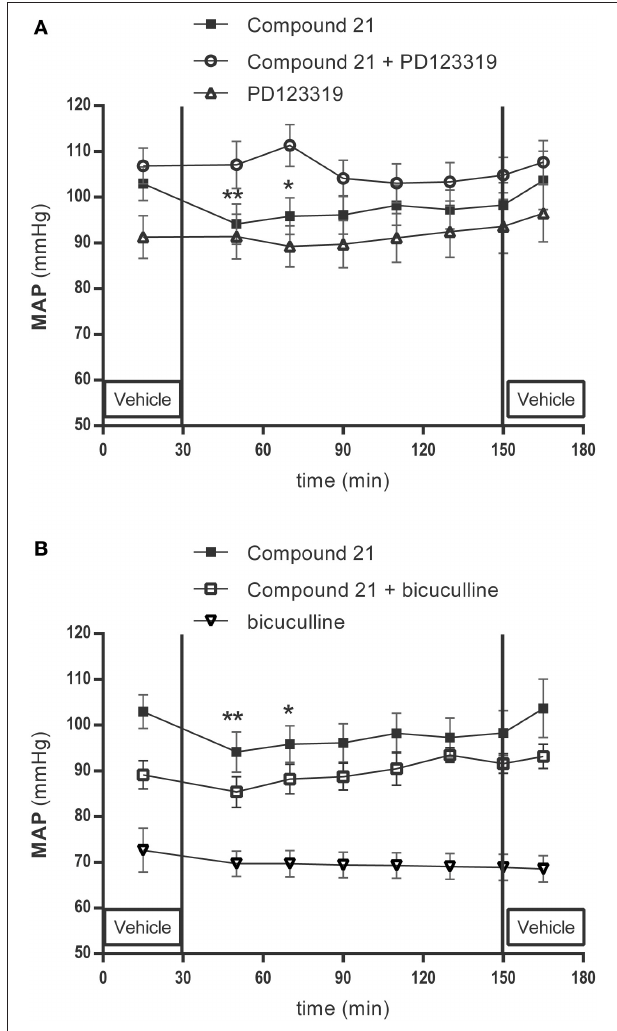
FIGURE 4 | Mean arterial pressure (MAP) measurement experiment: effect of infusion in the RVLM with the AT2R agonist C21 (0.05 µ g/ µ l/h) ( n = 6), co-infusion of C21 with the AT2R antagonist PD123319 (0.05 µ g/ µ l/h) ( n = 4) and infusion of PD123319 (0.05 µ g/ µ l/h) alone ( n = 9) (A) ; C21 (0.05 µ g/ µ l/h) infusion alone, co-infusion of C21 (0.05 µ g/ µ l/h) with the GABA-A R antagonist bicuculline (100 µ M) ( n = 7), or infusion of bicuculline alone ( n = 4) (B) on MAP in normotensive anesthetized Wistar rats. MAP was recorded every 2 s. C21, PD123319 and bicuculline were dissolved in modified Ringer’s solution and administered through the dialysis probe from time 30 to 150 min. Data are shown as mean ± SEM. Statistical analysis for intragroup differences of the treatment is performed using one-way ANOVA for repeated measures and the Dunnett’s multiple comparison test; significant data compared to the mean of baseline values are indicated by asterisks (* p < 0.05; ** p < 0.01).